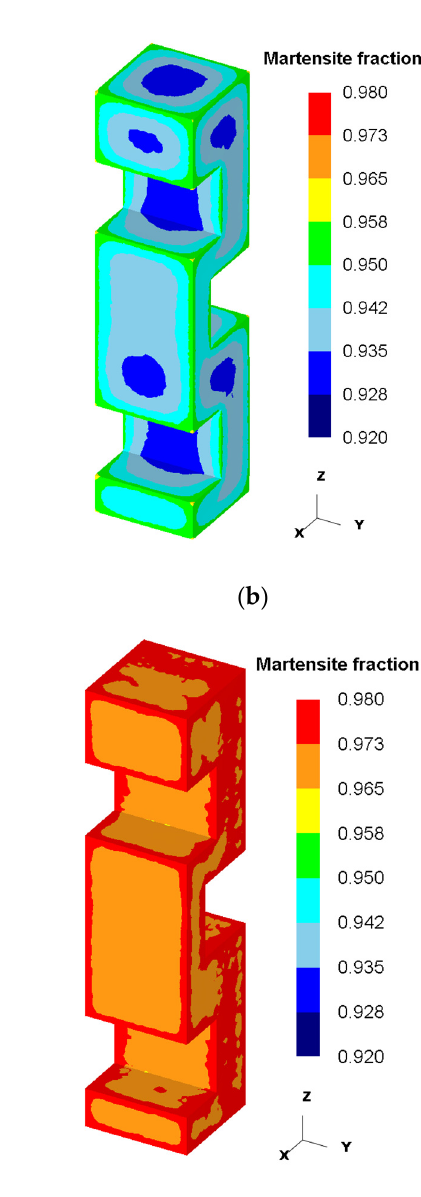
Figure 9. Nodal transformed fraction in quenched samples: ( a ) V-OQ; ( b ) H-OQ; ( c ) V-WQ; and ( d ) H-WQ.